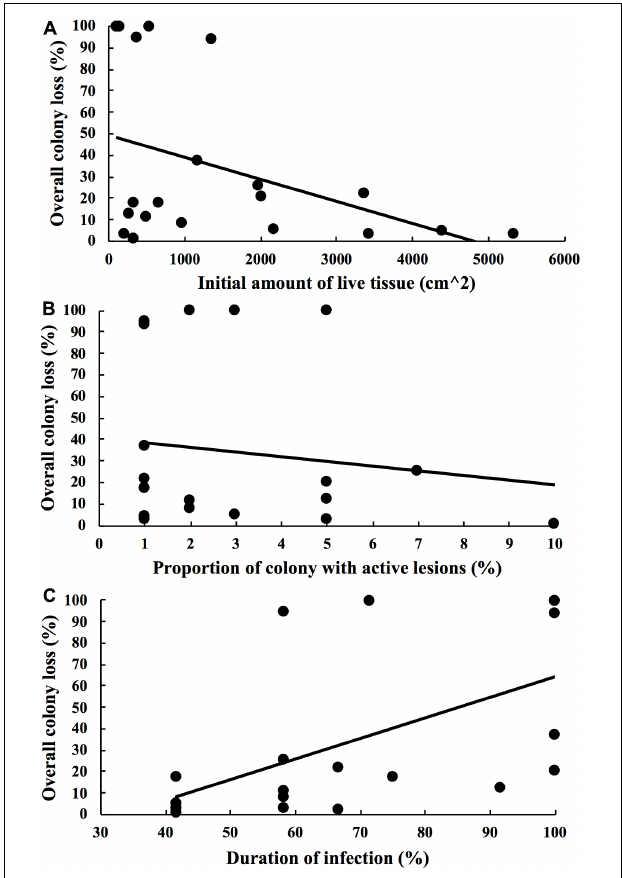
FIGURE 5 | Scattergrams showing the relationship between the overall colony loss from disease after 1 year and (A) initial amount of health tissue on colonies at the start of the study, (B) proportion of colony with active lesions at the start of the study and (C) duration of the infection during the 1 year study period. 20 Montastrea cavernosa colonies with SCTLD were tagged and followed through time for 1 year.